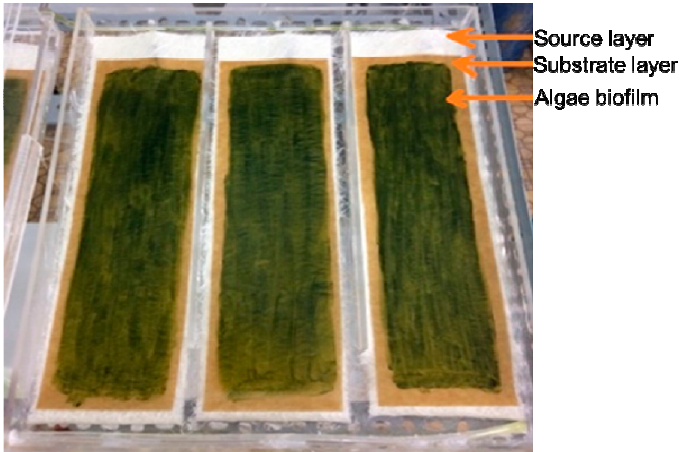
Figure 1. A chamber of a small-scale angled porous substrate photobioreactor (PSBR) was used in the experiments.